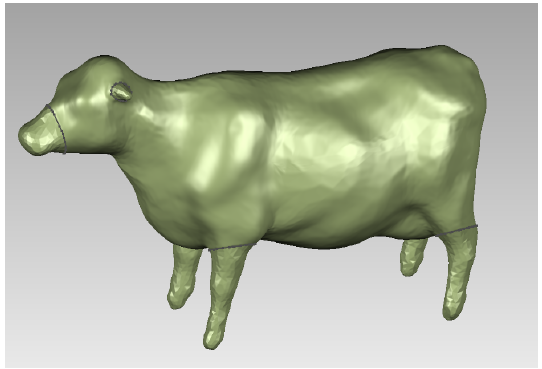
Figure 5. Surface model of